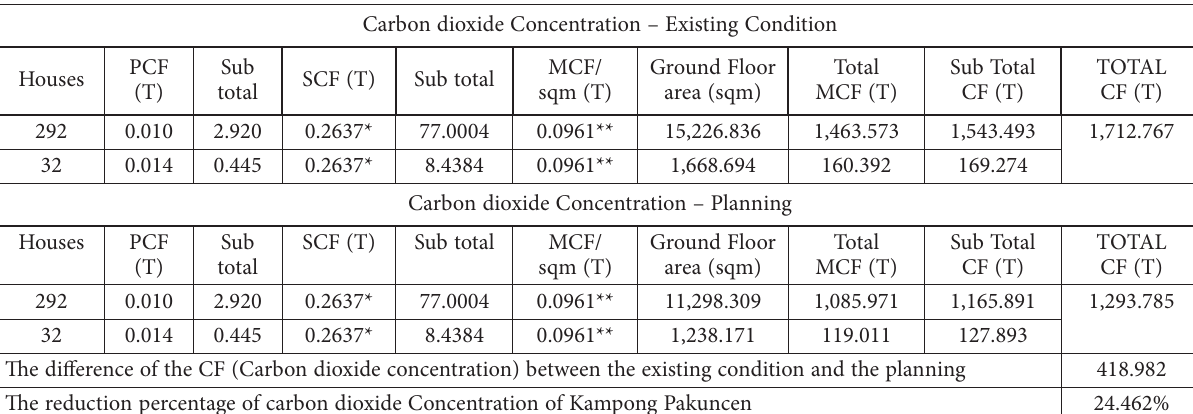
Table 6. Carbon Footprint of Kampong Pakuncen – existing and planning per